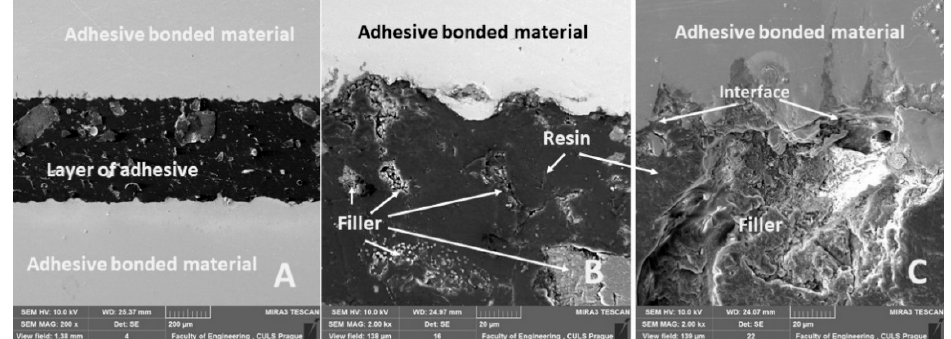
Figure 7. Adhesive bond ABFE2 cross-section: ( A ): total view of adhesive bond (MAG 200 ×), ( B ) filler distribution in adhesive layer and interface of resin, filler and bonded material (MAG 2.00 k×), ( C ): detailed view of interface of adhesive layer and bonded material (MAG 2.00 k×).